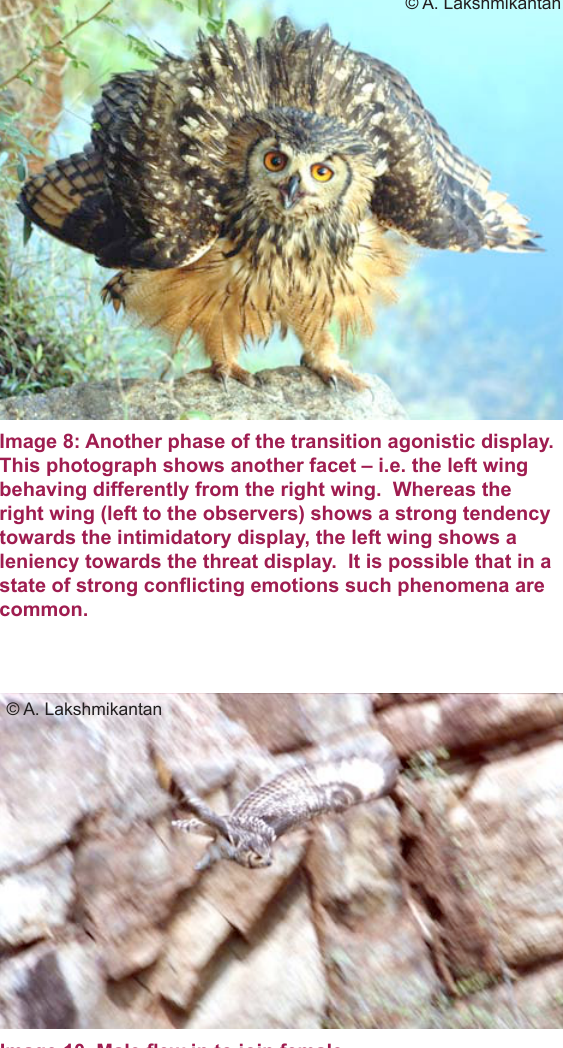
Image 10. Male flew in to join female.